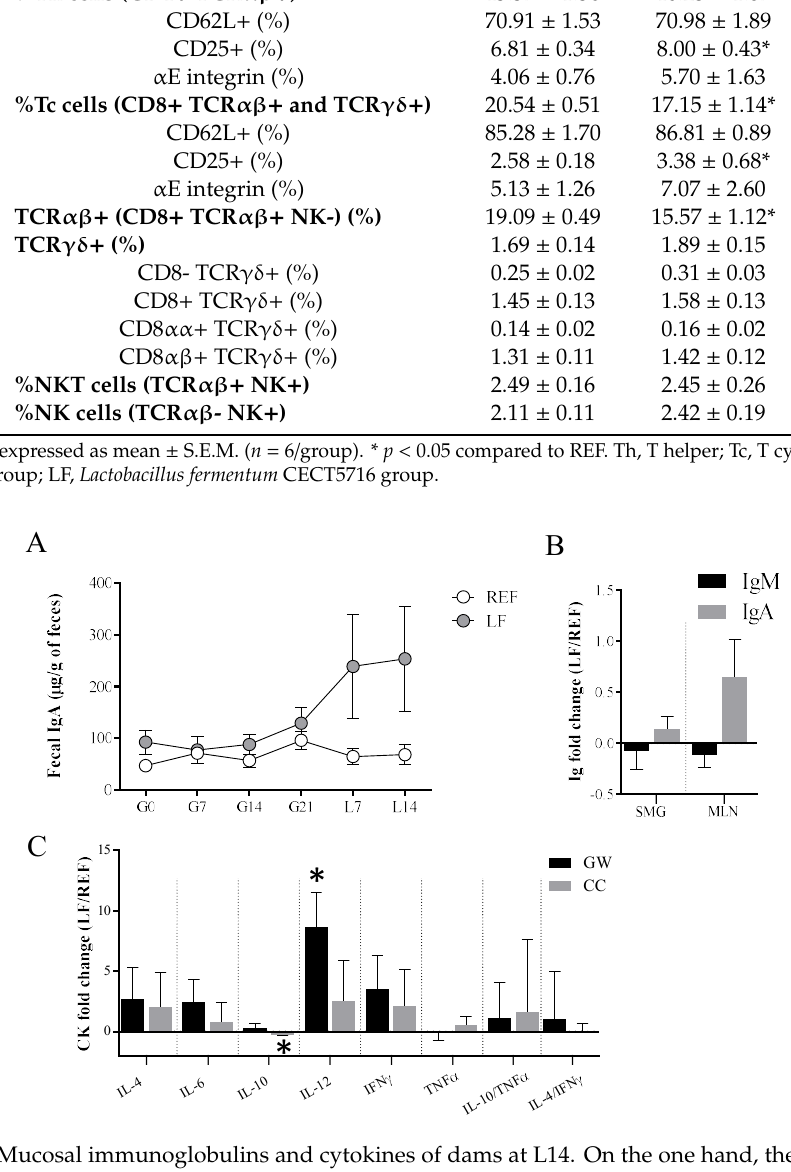
Table 4. Evolution of pH, humidity and weight of the dams’ feces throughout the study.